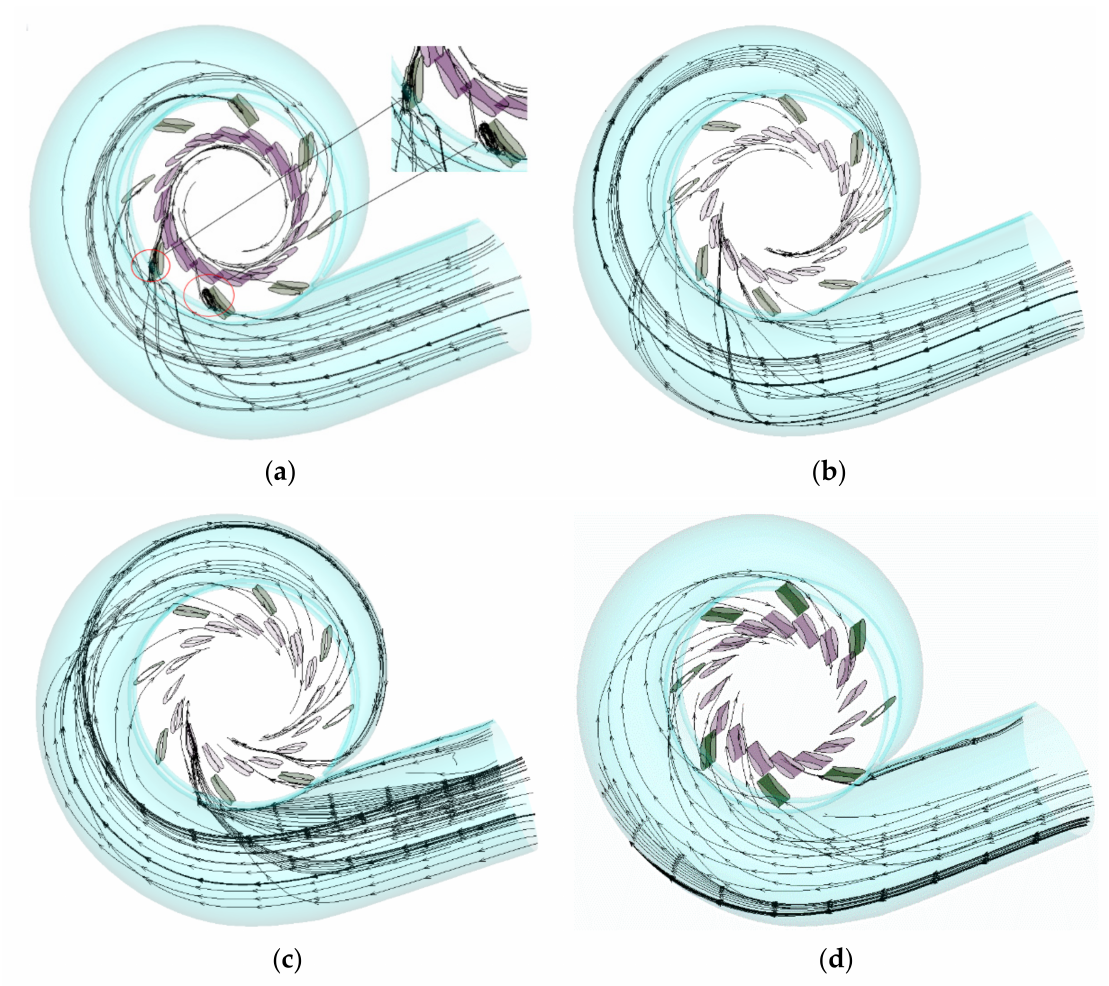
Figure 6. Flow line diagram of spiral case and guide apparatus. ( a ) α = 13.50 mm (small opening condition); ( b ) α = 26.17 mm; ( c ) α = 38.05 mm; ( d ) α = 48.74 mm (optimal